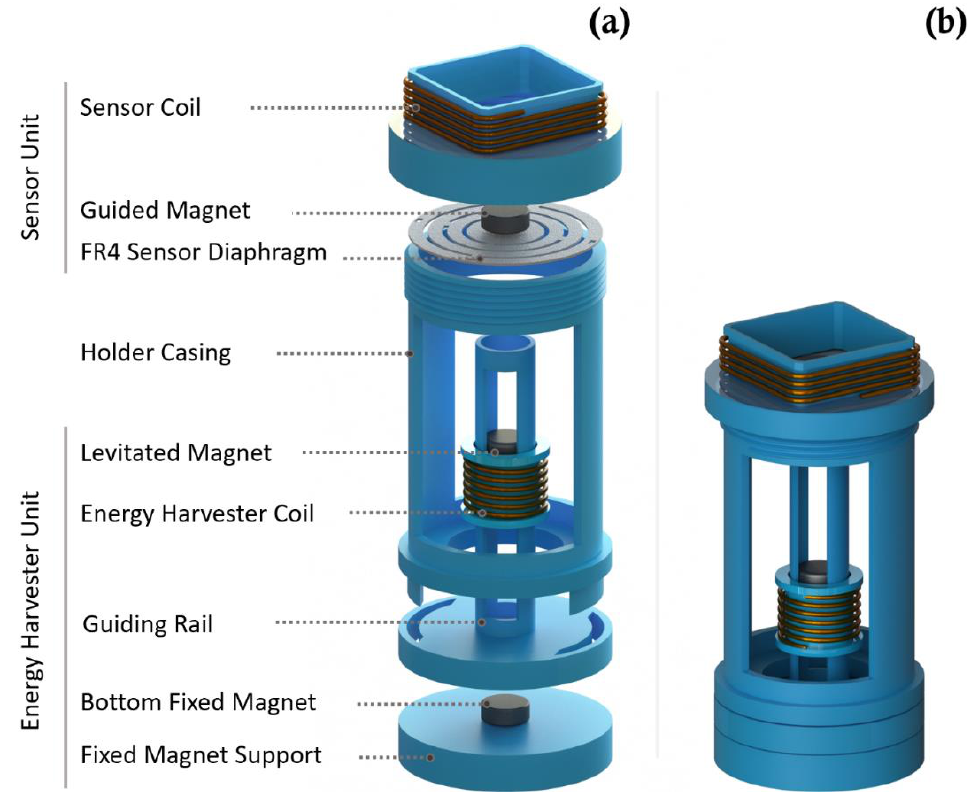
Figure 3. Design and 3D view of the structure of the vibration energy harvester-sensor unit presented in this work: ( a ) exploded view and ( b ) collapsed view.